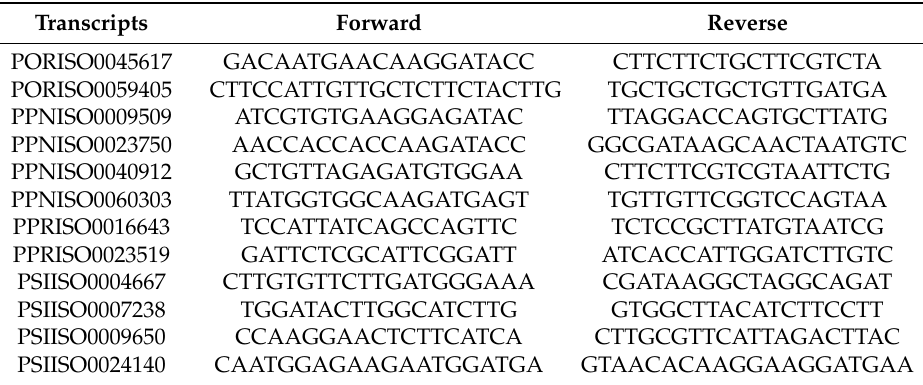
Table 2. List of primers used for